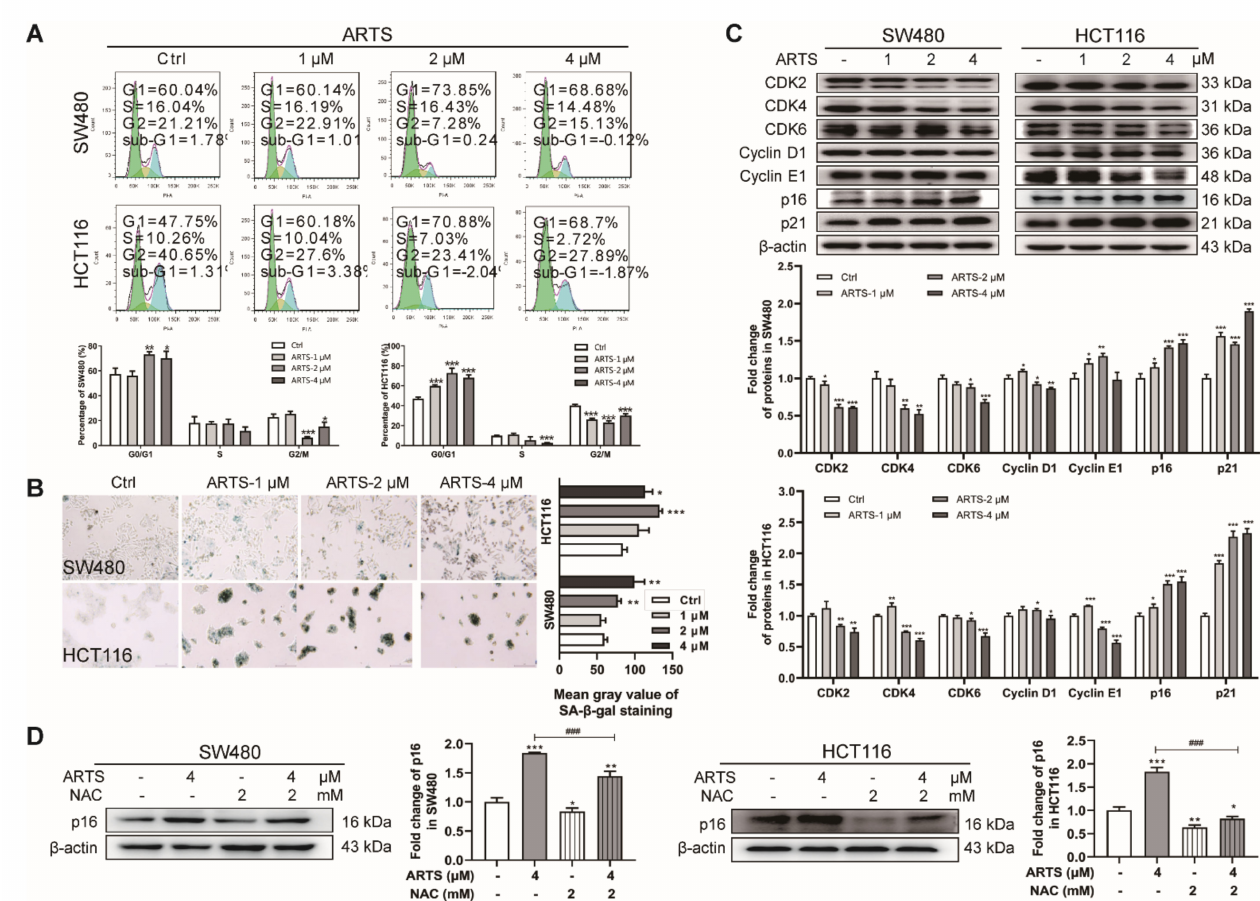
Figure 3. Artesunate caused excessive mitochondrial ROS to induce cell senescence and inhibit cell proliferation. ( A ) Artesunate arrested cell cycle at G0/G1 phase in SW480 and HCT116. Cells were seeded in 6-well plates. Once attached, cells were maintained in FBS-free medium for about 16~24 h. Afterwards, cell were treated with artesunate (1, 2, and 4 µ M in medium containing 10% FBS) for 72 h and then harvested for PI staining to analyze cell cycle by flow cytometry. ( B ) Artesunate induced cell senescence in SW480 and HCT116. Cells were seeded in 6-well plates and treated with artesunate (1, 2, and 4 µ M) for 72 h. Cell senescence was represented via SA- β -gal activity, which was assayed using a SA- β -gal staining kit after artesunate treatment. ( C ) Artesunate treatment downregulated the protein levels of CDK 2/4/6 and upregulated the protein levels of CDKIs, p16, and p21 in SW480 and HCT116. Cells were seeded in 60 mm dishes and treated with artesunate (1, 2, and 4 µ M) for 72 h. Then, cells were lysed with RIPA to extract total protein. The protein levels were measured by western blotting. The gray values of protein blots were evaluated by Image J. Relative protein expression was normalized to β -actin. ( D ) NAC attenuated the effect of artesunate on protein expression of p16 in SW480 and HCT116. NAC was used at a concentration of 2 mM and added alone or together with artesunate (4 µ M) for 72 h. * p < 0.05, ** p < 0.01, and *** p < 0.001 vs. Ctrl. ### p < 0.001 vs. cells treated with artesunate alone. Data were shown as mean ±